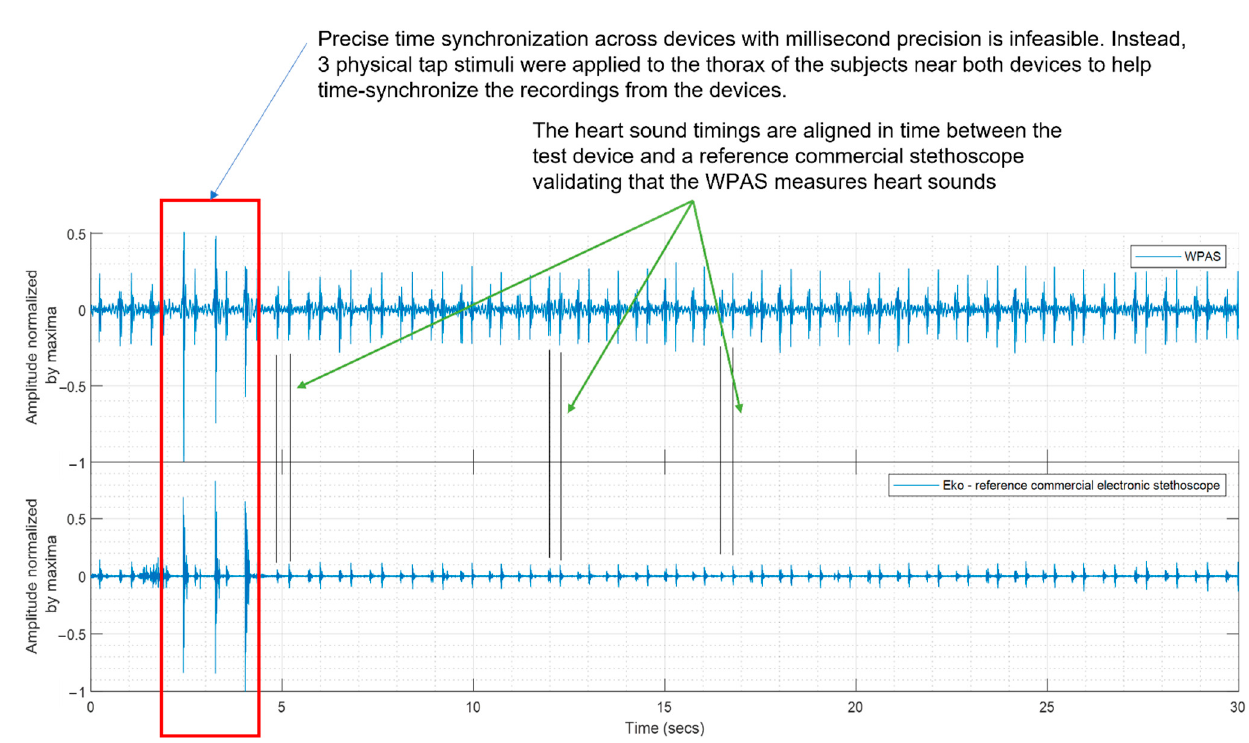
Figure 4. Manifestation of the physical tap as recorded by the WPAS and Eko device. Table 2. List of activities and their duration and/or repetitions.